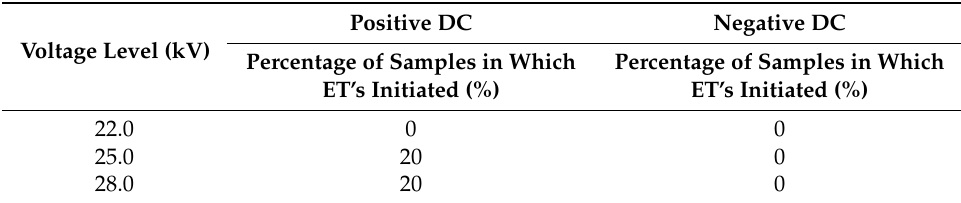
Table 1. Tree inception at continuous DC voltages.